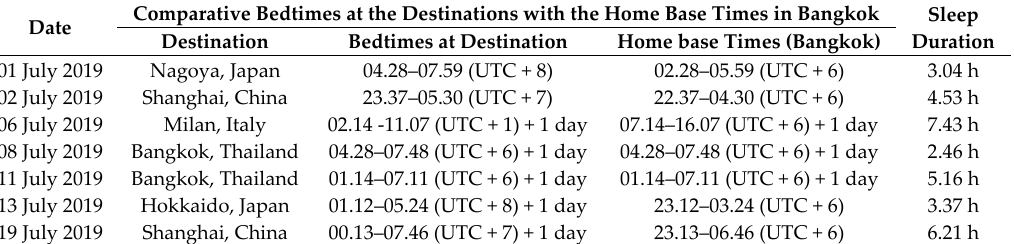
Table 10. Analyzed data from the Fitbit application of the 2nd Male Flight Attendant.